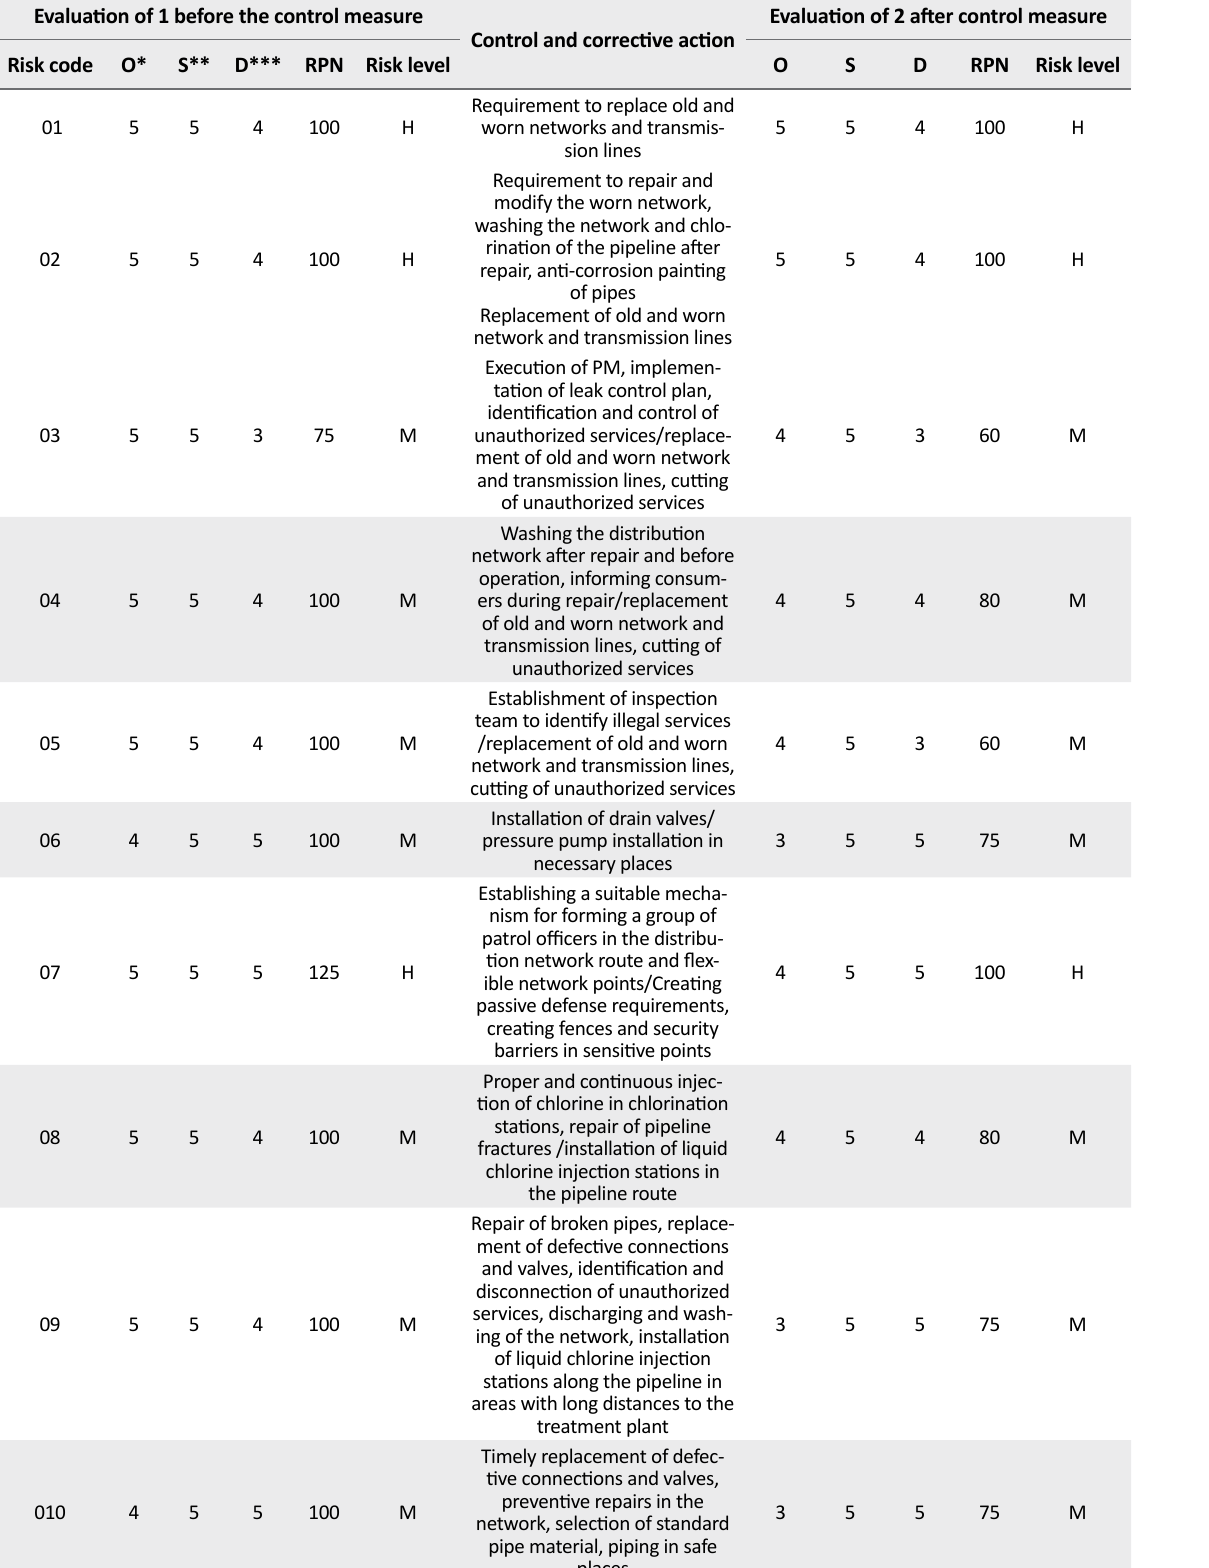
Table 5. Assessment and prioritization of risk and control and corrective actions based on worksheets in the distribution net - work and point of consumption of FMEA Evaluation of 1 before the control